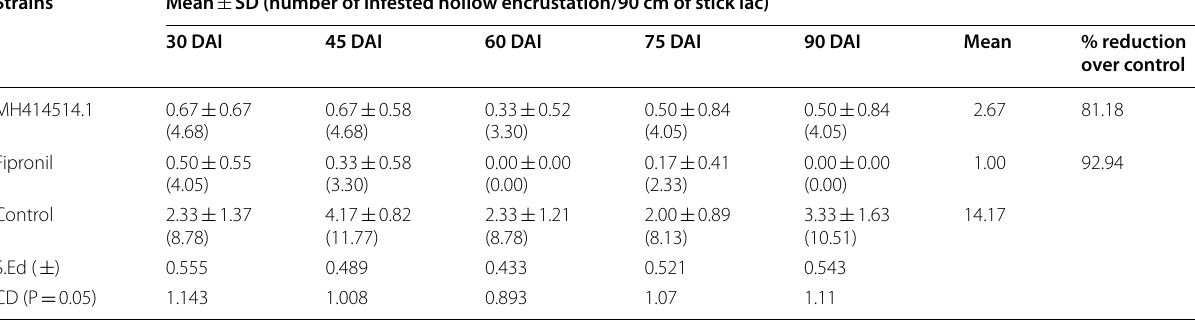
Data are mean of 7 replications. Data within the parentheses are angular transformed value DAI days after inoculation of